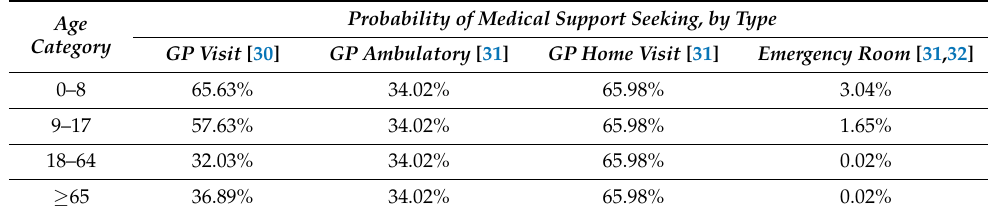
Table 6. Medical support seeking by patients with a symptomatic case of influenza.